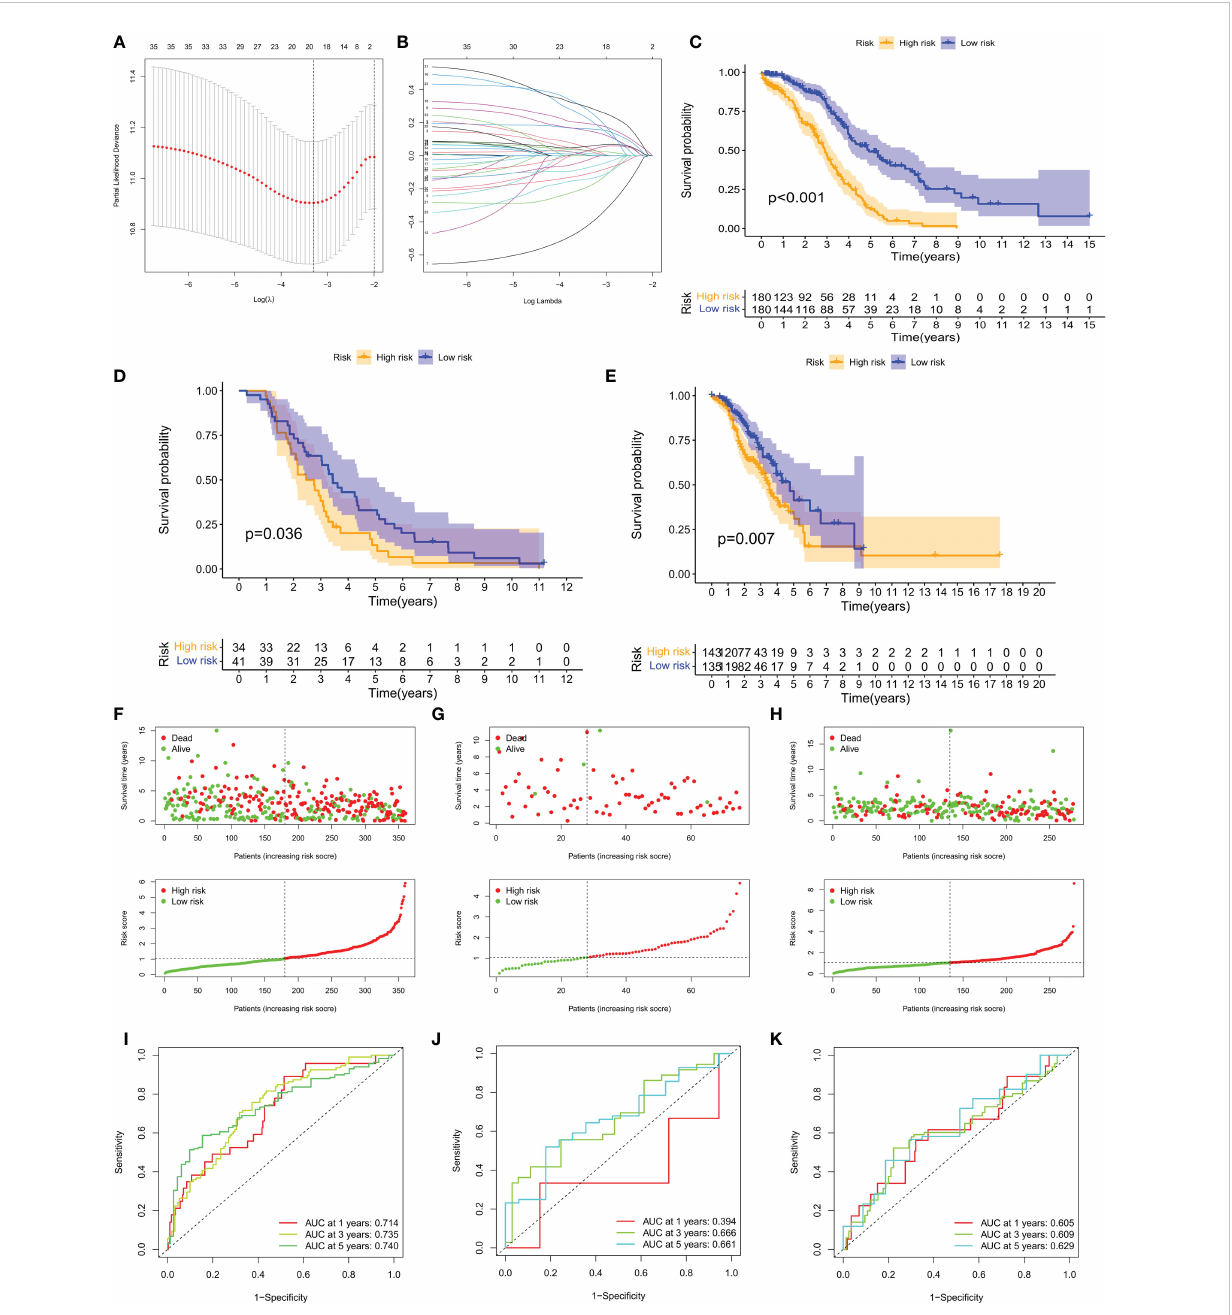
FIGURE 5 Construction of CMRGPS and prognostic value of risk scores. (A, B) Linear models (Lasso) were constructed and coef fi cients were visualized using LASSO Cox regression to identify 19 copper metabolism-related DEGs. (C – E) Kaplan-Meier survival curves showing the risk strati fi cation ability of the TCGA-OV, GSE63885, and GSE9891 cohorts. (F – H) Risk plots were used to illustrate the survival status of each sample in the TCGA-OV, GSE63885, and GSE9891 cohorts. (I – K) AUC values for risk scores at 1, 3, and 5 years in the TCGA-OV, GSE63885, and GSE9891